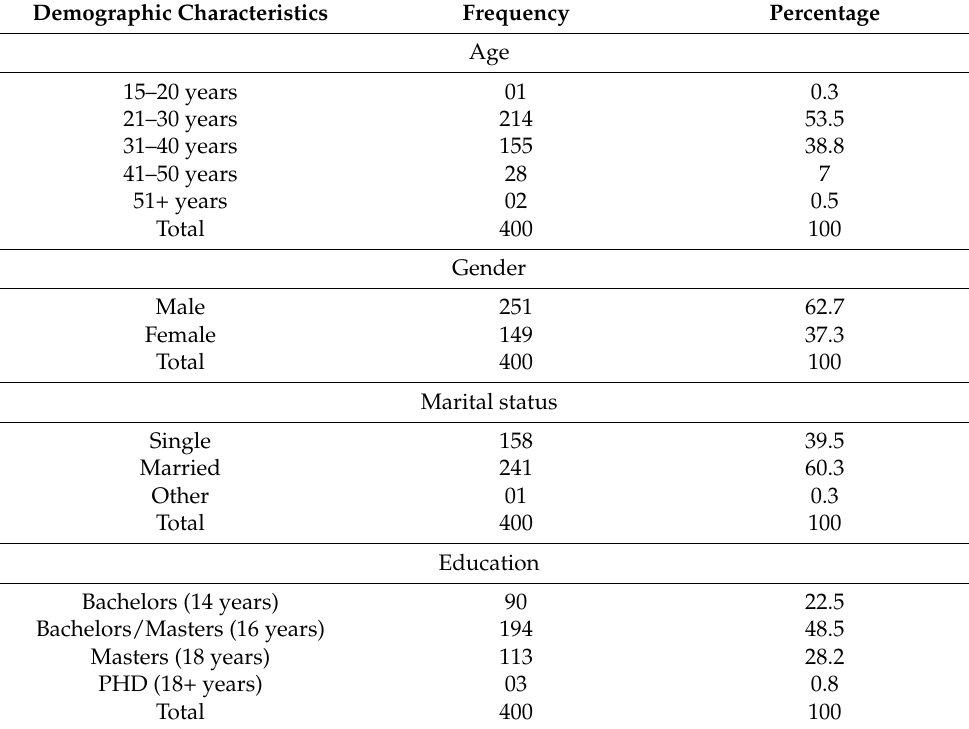
Table A1. Demographic information. Demographic